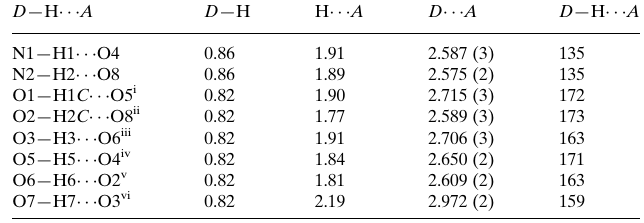
Hydrogen-bond geometry (A˚ , (cid:3)